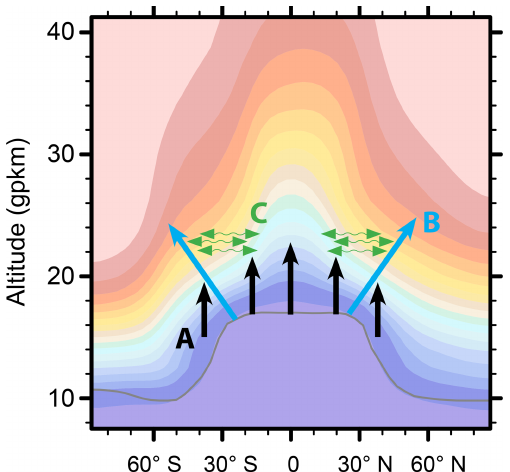
Figure 1. Schematic illustration of the location and direction of the effects of the upward shift trend (A), the maximal AoA gradient (B) and the aging-by-mixing decrease (C) on the AoA trend. The col- ors indicate the climatological zonal mean AoA distribution of the 1960–2000 period in the CMAM REF-C2